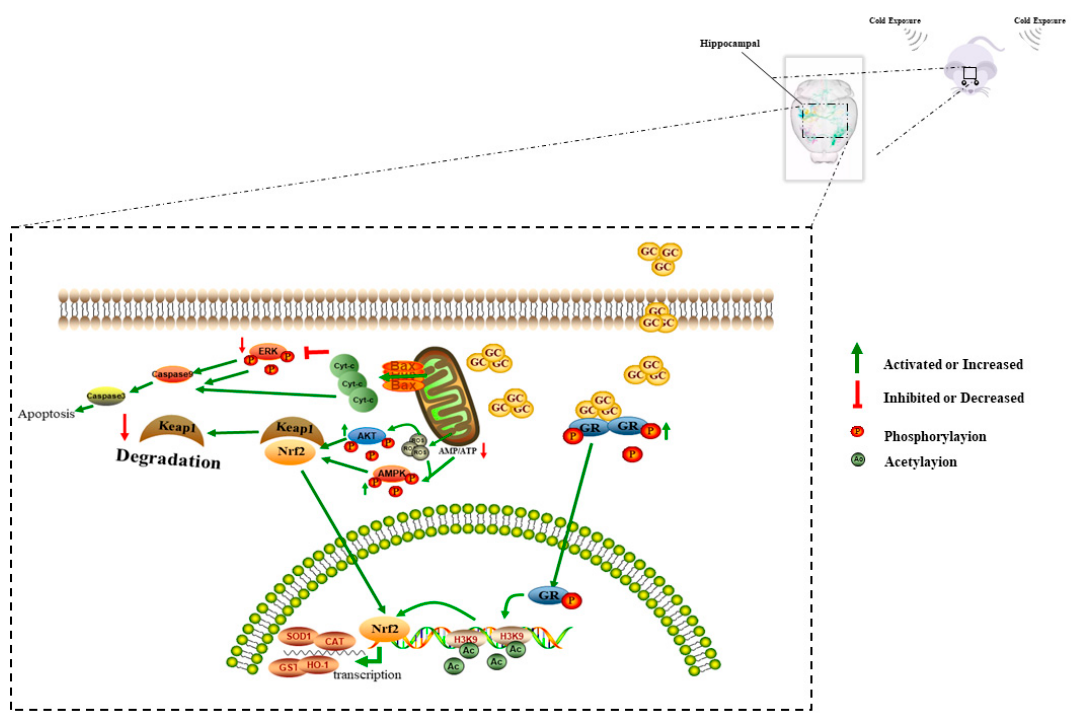
Figure 14. A proposed model for molecular mechanisms involving neuronal apoptosis related to cold stress through CORT in the hippocampi of adolescent mice.